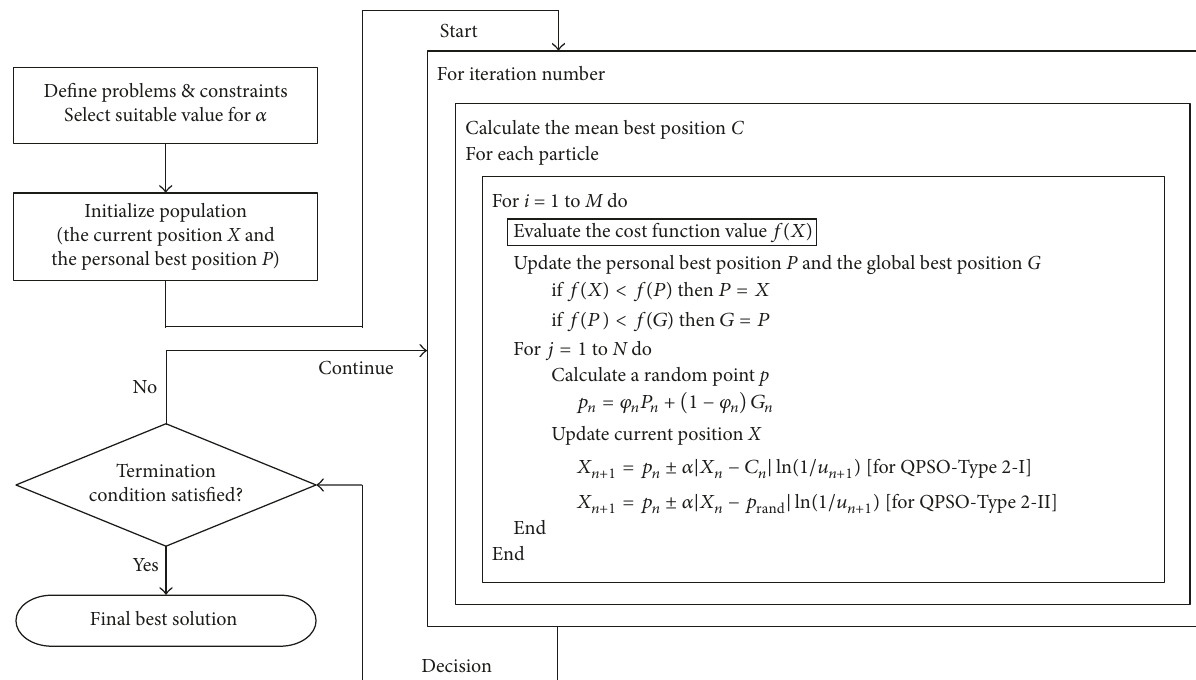
Figure 7: Flowchart of the QPSO algorithm.